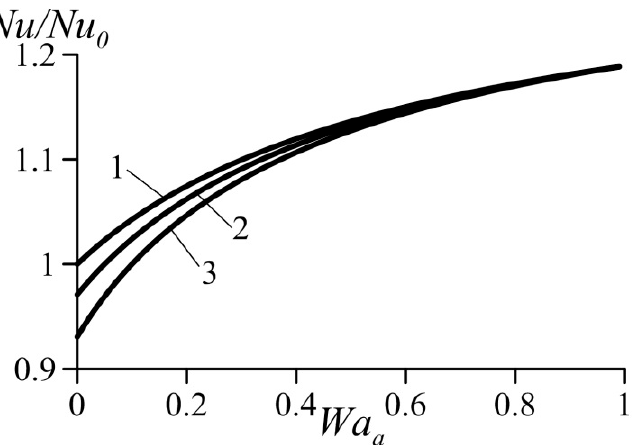
Figure 5. Effect of van der Waals number Wa a on the normalized Nusselt number under condition Wa b = const. 1— Wa b = 0, 2— Wa b = 0.1, 3— Wa b = 0.2.